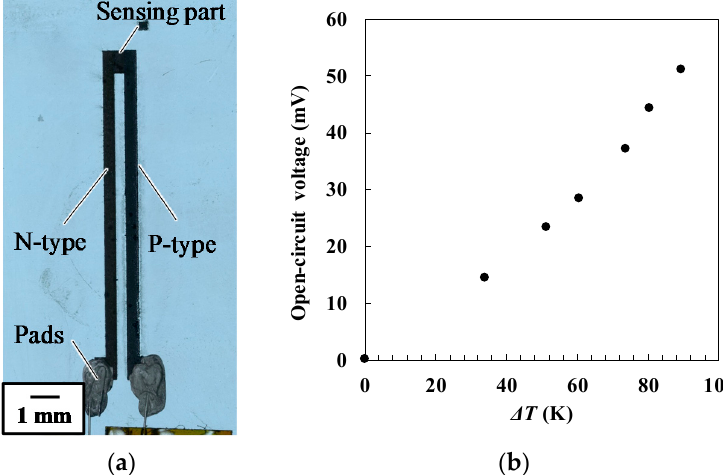
Figure 7. ( a ) Photograph of a sample thermocouple fabricated by selective micropatterning, ( b ) relationship between the open-circuit voltage and the temperature difference between sensing hot and cold.